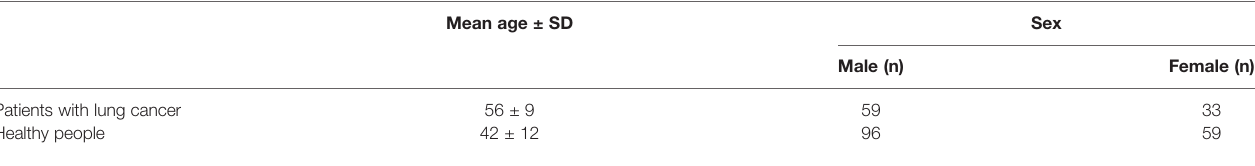
TABLE 1 | The information of patients with lung cancer and healthy